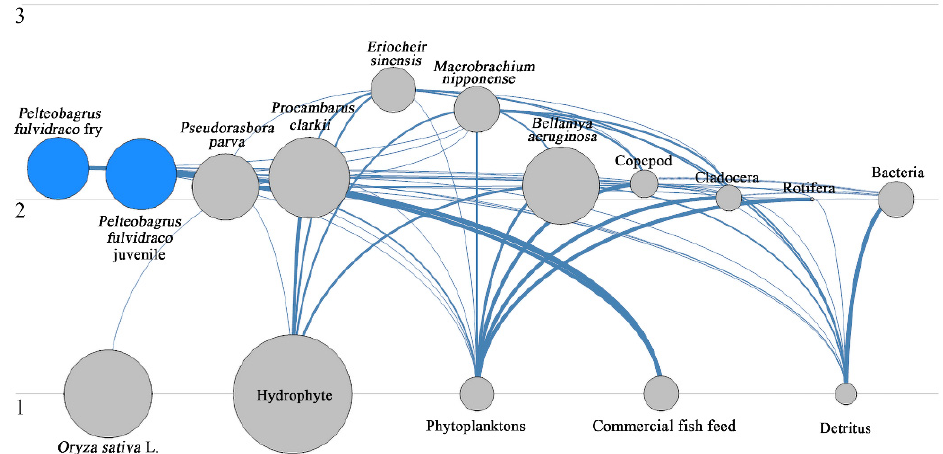
Figure 2. Trophic structure of the FMRP. Circles represent functional groups, the size of a circle represents biomass size, numbers represent effective trophic levels, and the lines represent the direction of energy flow and predation relationship.